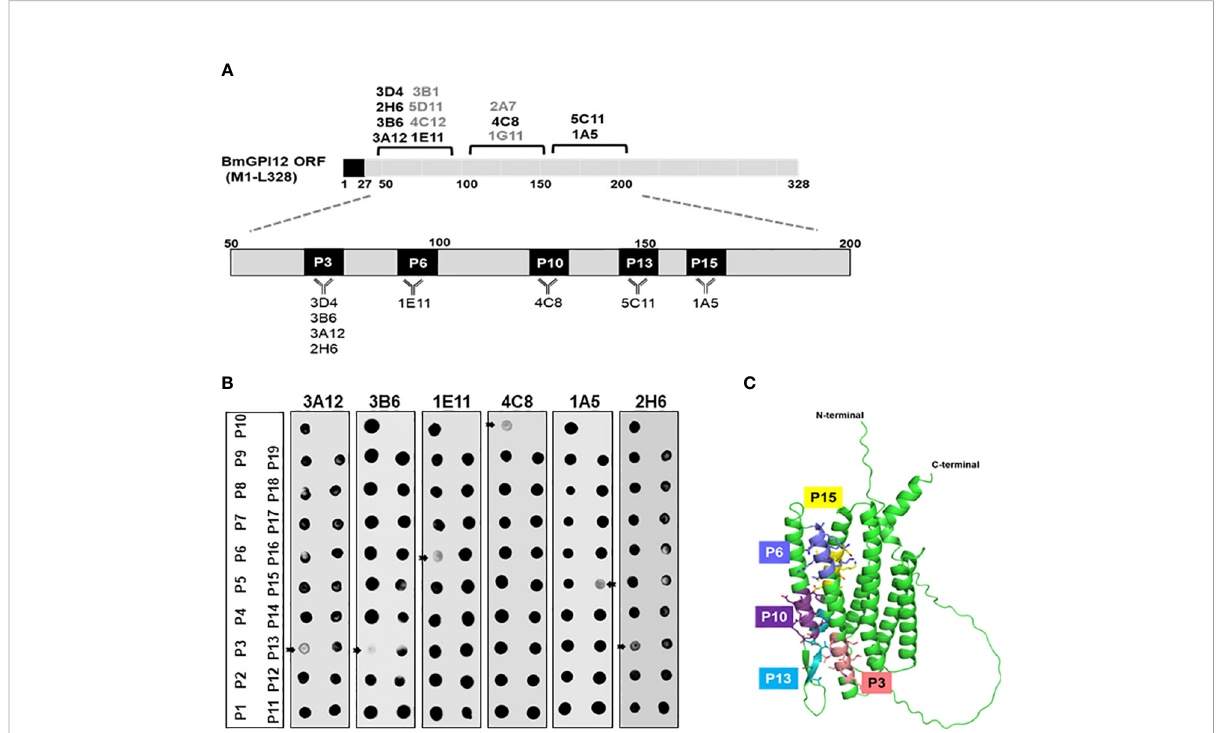
FIGURE 8 Epitope mapping of BmGPI12 monoclonal antibodies using overlapping peptides and localization of the peptides on the predicted BmGPI12 structure. (A) Schematic representation of the binding sites of 13 monoclonal antibodies to the BmGPI12 antigen. The speci fi c 11-amino acid binding sites (P3, P6, P10, P13 and P15) recognized by the 8 monoclonal antibodies on BmGPI12 are highlighted. (B) Panels represent dot blot- based competition assays used to examine the interaction between the BmGPI12 antigen and various monoclonal antibodies in the presence of each of the overlapping nineteen 11-amino acid peptides (P1-19). The panel shows the analysis for 3A12, 3B6, 1E11, 4C8, 1A5 and 2H6 monoclonal antibodies. Arrows indicate where speci fi c peptides block the binding of the MAb to the antigen. (C) Predicted three-dimensional structure of BmGPI12 and the location of the P3, P6, P10, P13 and P15 peptides.